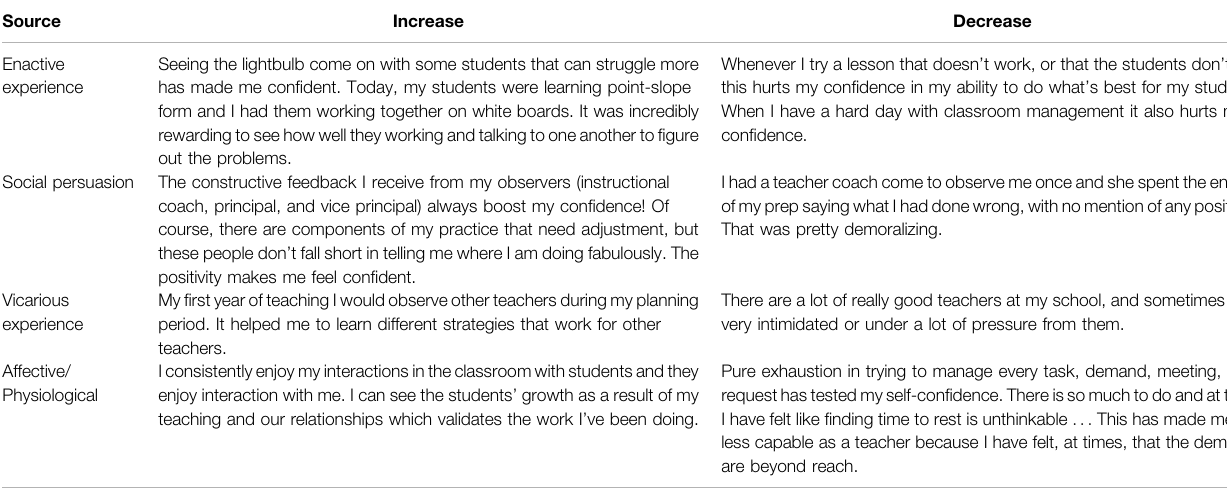
TABLE 6 | Illustrative examples of open-ended survey responses by self-ef fi cacy source. Source Increase Decrease Enactive experience